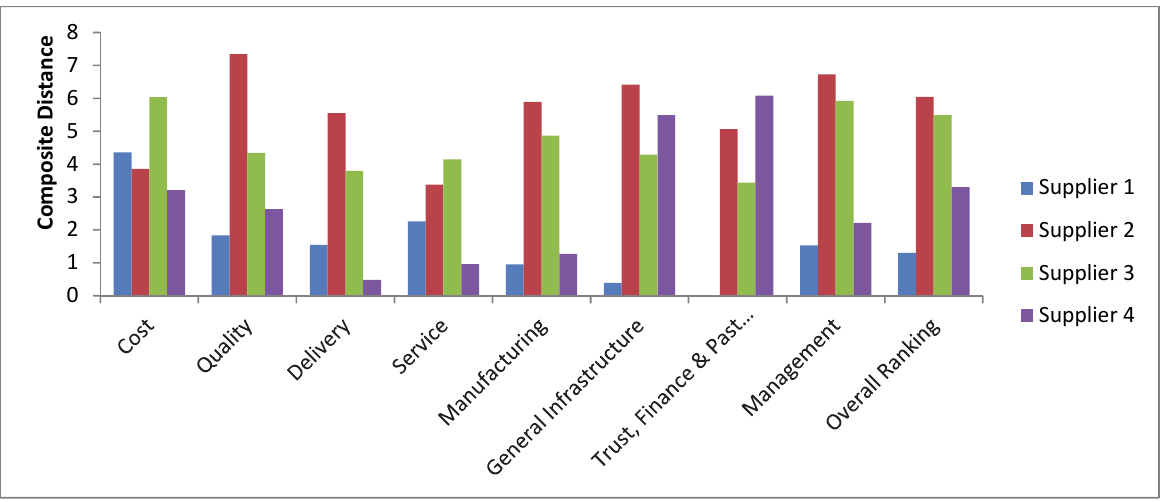
Fig. 2. Ranking of